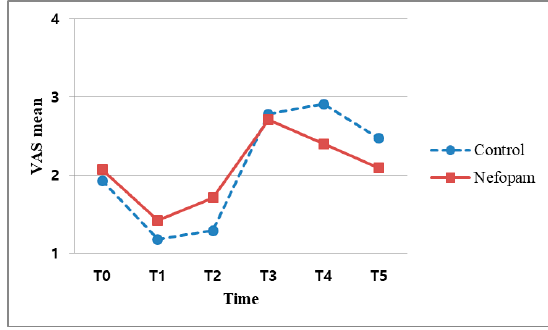
Figure 4. Association between VAS scores and time points after interscalene block. Table 4. Association in VAS between nefopam group and control group regarding block.